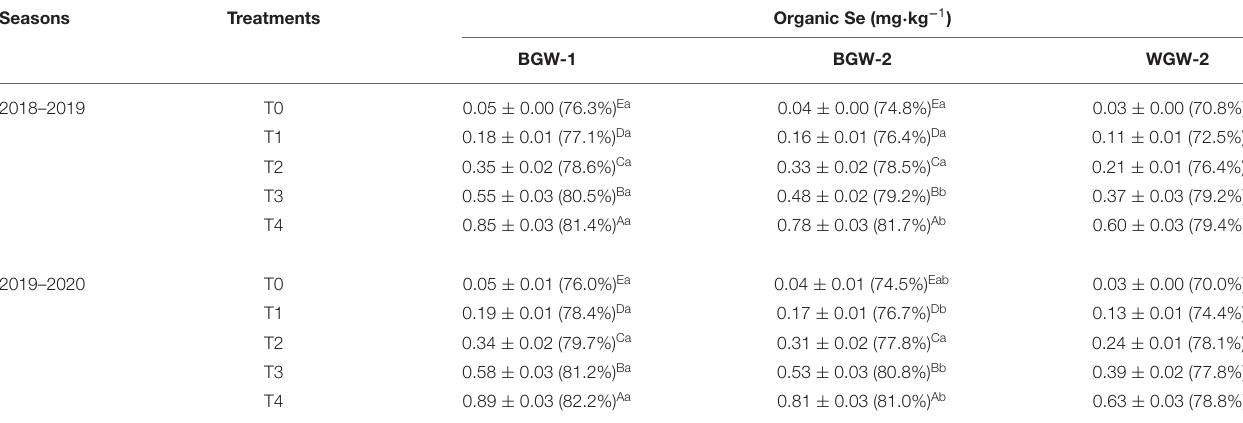
TABLE 6 | Effects of Se fertilization on organic Se concentration in the grain of wheat in the two growing seasons. Seasons